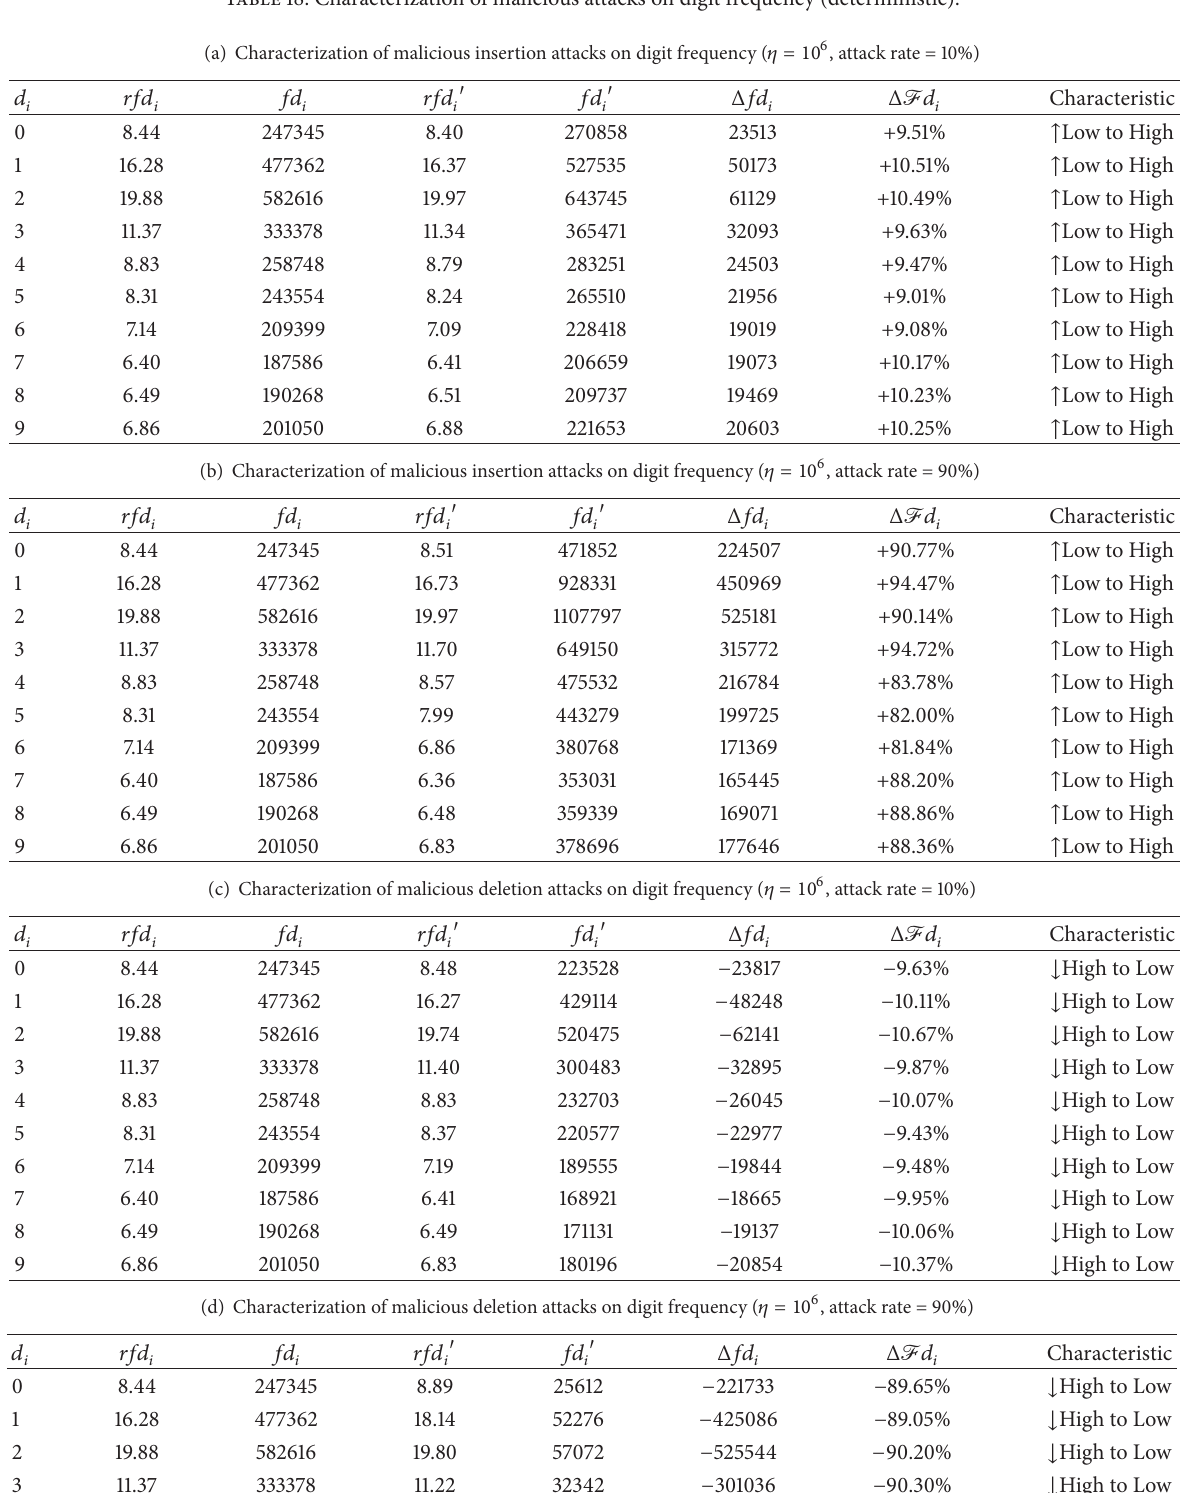
Table 18: Characterization of malicious attacks on digit frequency